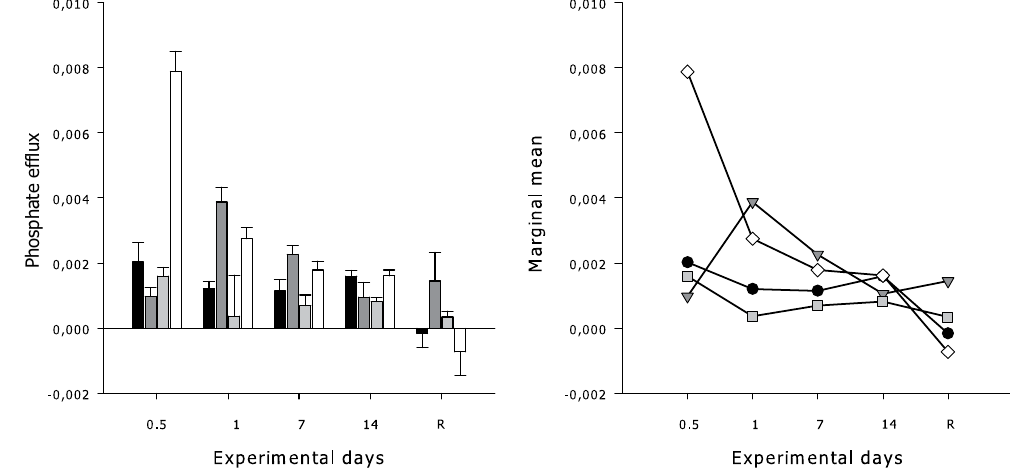
Figure 3. Left panel –Mean net phosphate efflux rate ( μ mol PO 43 − g(tissue DW) − 1 h − 1 ) ± 1 S.E. (n = 5) by G. barretti explants exposed to four different temperature levels (7 °C–Black bar, 9 °C–Dark grey bar, 11 °C– Light grey bar & 12 °C–White bar) over a 14 d experimental period. R on the x-axis is respiration at 65 d post exposure (the recovery period), with explants being maintained at ambient temperatures (7 °C) after the 14 d experimental period, irrespective of prior temperature exposure. Right panel –Interaction plot of estimated marginal means of PO 43 − flux rates calculated for each temperature (7 °C–Black circles, 9 °C–Dark grey triangles, 11 °C–Light grey squares & 12 °C–White diamonds) at each exposure day and recovery time period